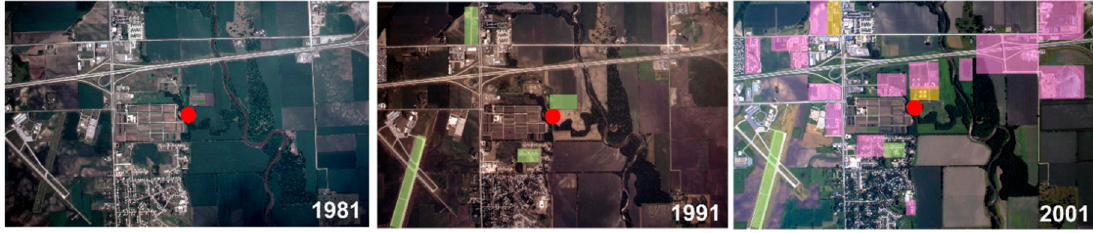
Figure 5. Specific land use modifications near the Ames site from 1981–2001. Satellite images at ten-year intervals from 1981 to 2001 were used to identify locations that underwent substantial changes in land use. The red dot denotes the trap location, while specific changes are displayed in green (occurring between 1981–1991), purple (occurring between 1991–2001), or yellow (occurring between 1991–2001 at a location that had previously been modified).